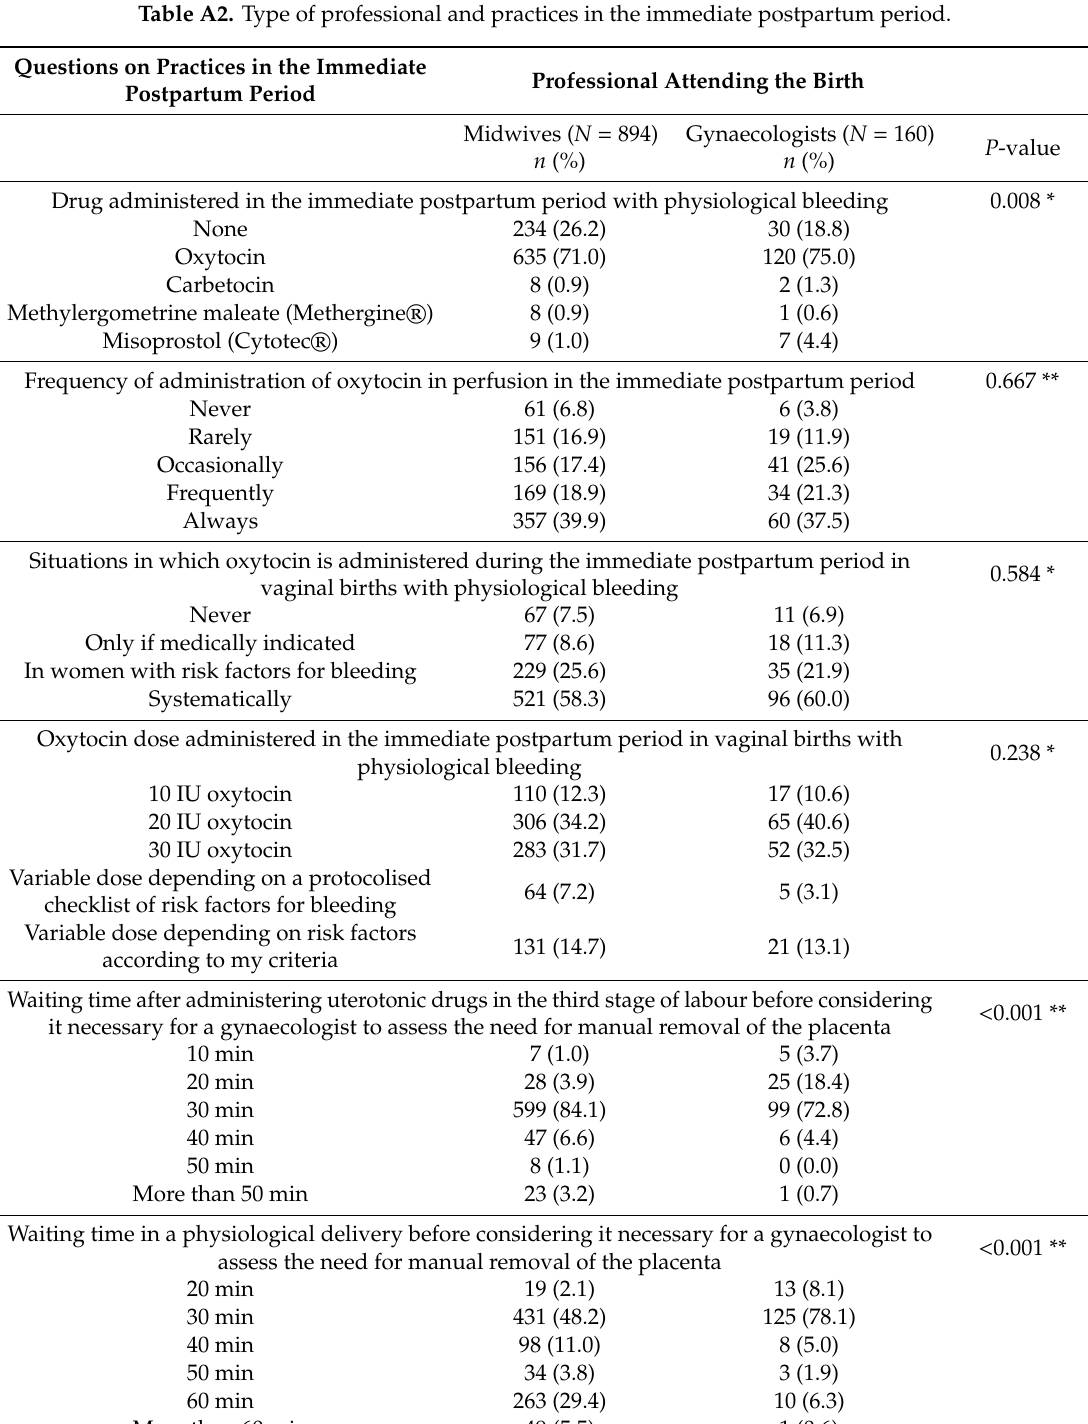
Table A2. Type of professional and practices in the immediate postpartum